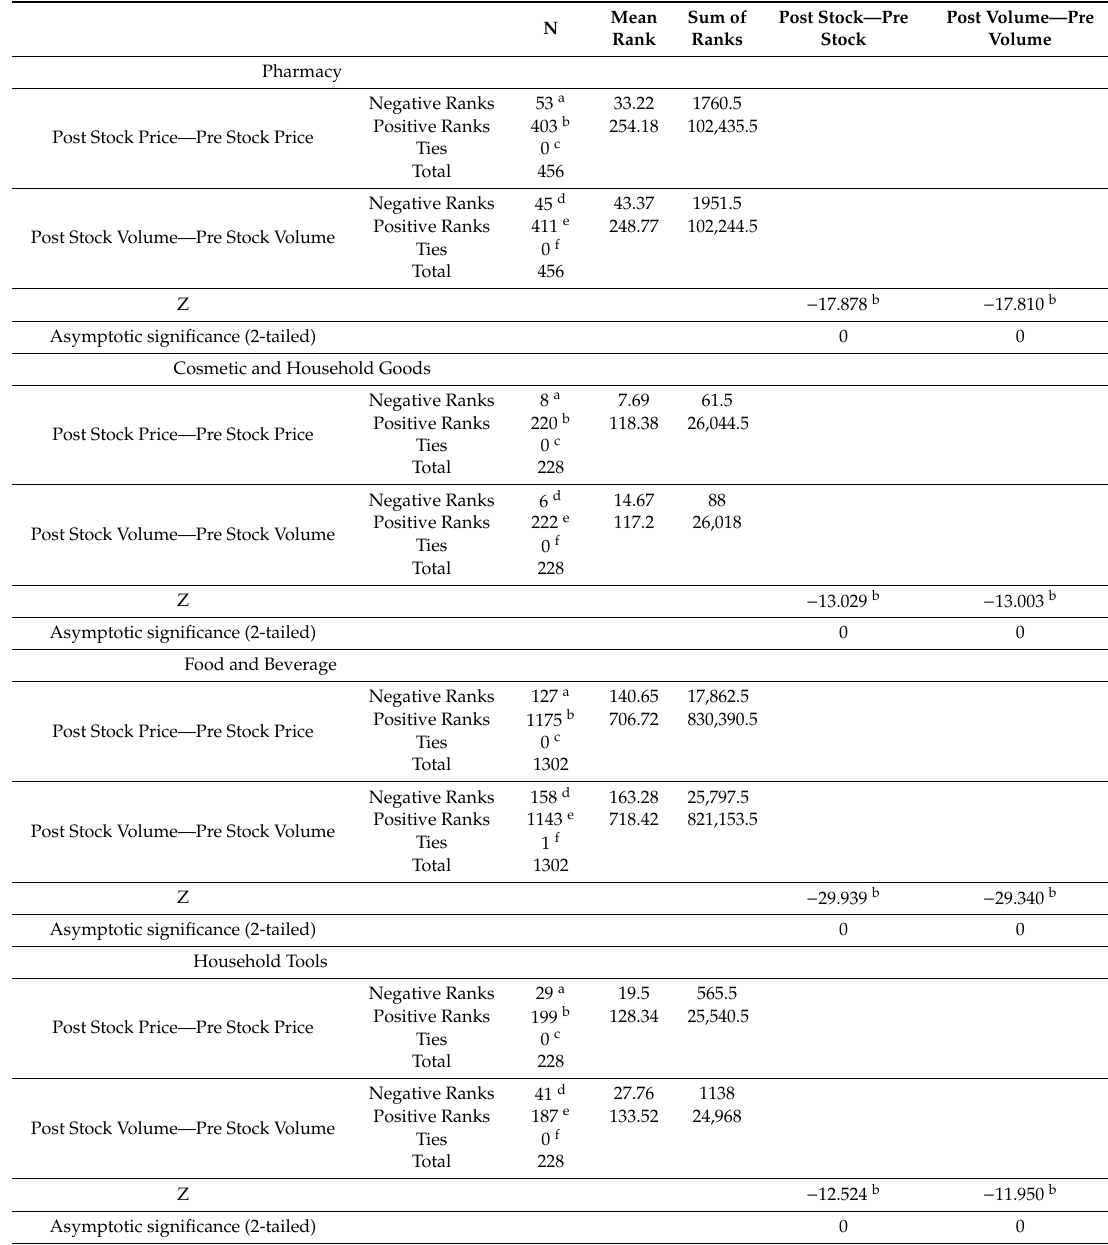
Table 3. Research results for di ff erent types of industry based on multiple regression